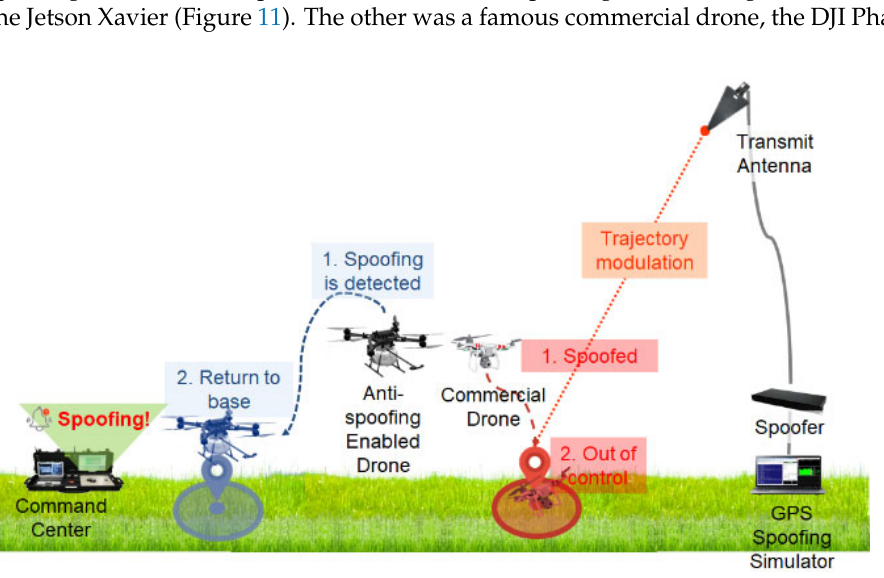
Figure 9. Test result of Mavic drone.